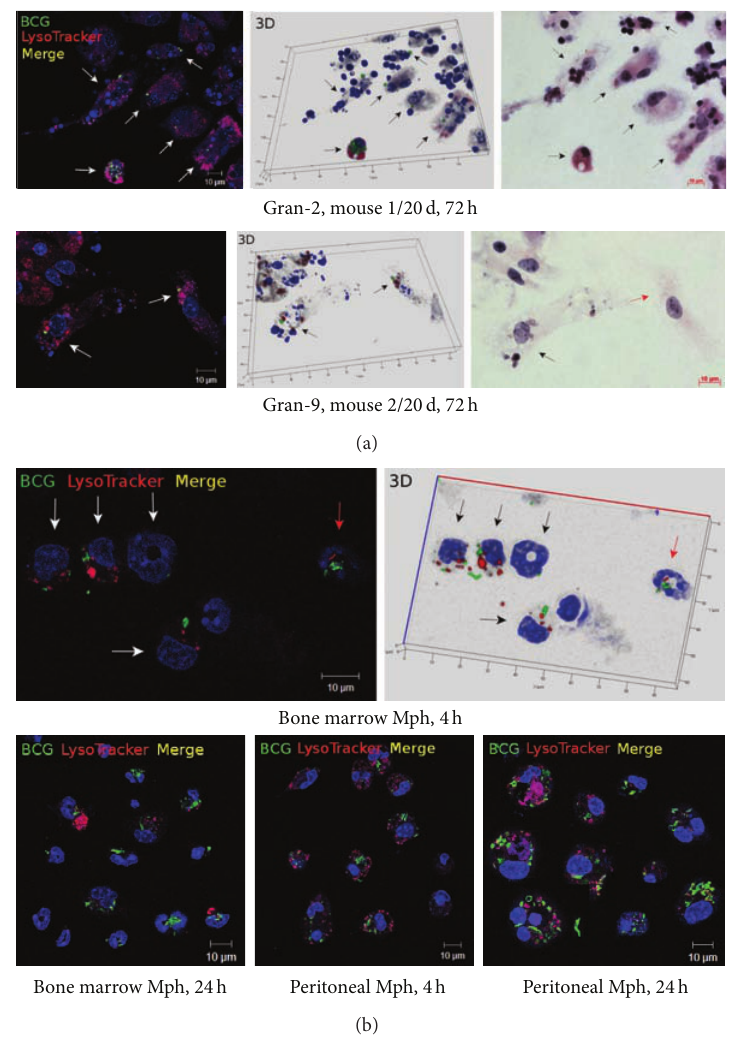
Figure 5: Representative confocal fluorescent images of macrophages (Mph) stained by the LysoTracker Red DND-99 dye (red signal) and mycobacterial LAM-specific antibodies (green signal) show lack of colocalization of BCG-mycobacteria with host cell lysosomes (lack of yellowsignal).NucleiarestainedbyDAPI(bluesignal).Thescalebarsare10 𝜇 meach.(a)Fragmentsofsplenicgranulomasfrommouse2on20 days following BCG infection in vivo . In the right panels, the same fragments as in the other panels restained for acid-fast BCG-mycobacteria by the ZN method. Macrophages containing BCG-mycobacteria are indicated by the white arrows on the fluorescent images (left panels) and the black arrows on the 3D (central panels) and ZN (right panels) images. The red arrow in the lower-right panel indicates a macrophage, which does not contain acid-fast BCG-mycobacteria but has one LAM-labeled BCG- Mycobacterium in it on the fluorescent images (left and central panels). (b) Cells with BCG-mycobacteria in the cultures of mouse bone marrow and peritoneal macrophages following infection with the BCG vaccine in vitro and after culture for several hours. Macrophages and neutrophils with BCG-mycobacteria in them are indicated by the white and red arrows, respectively, on the fluorescent image (upper-left panel) and the black and red arrows, respectively, on the 3D image (upper-right panel). Abbreviations as in Figure